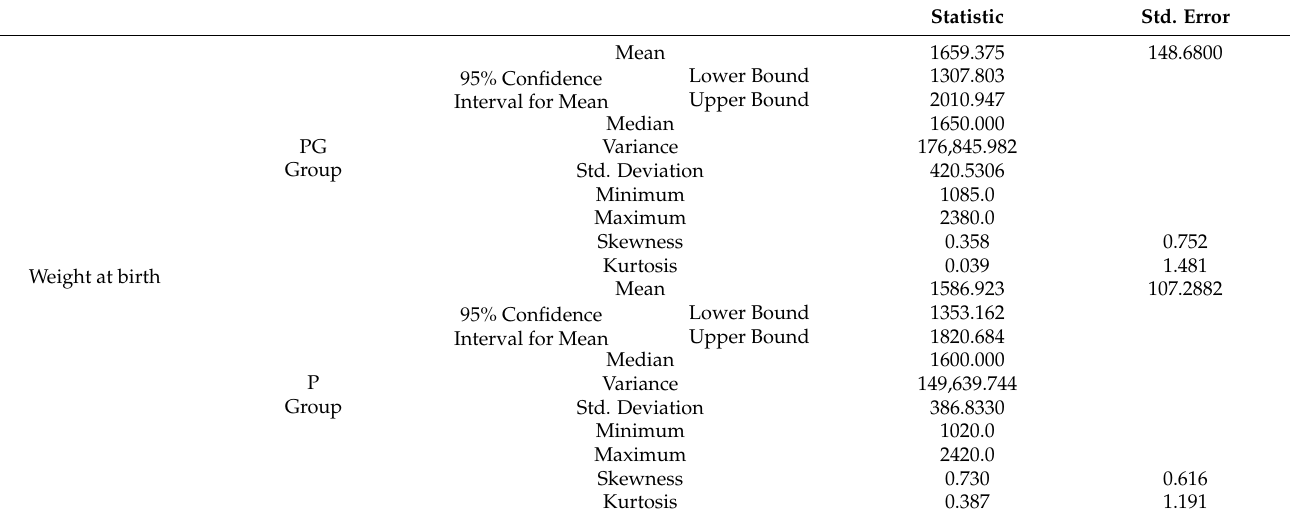
Table 3. Birth weight variables in both groups.